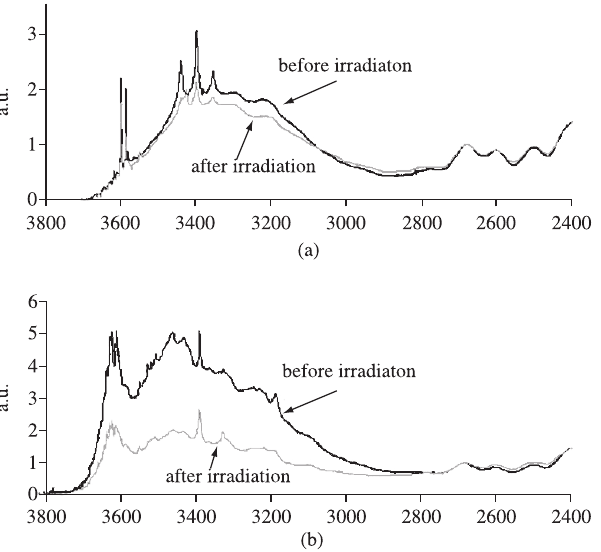
Figure 4. Infrared spectra at 93 K of a) amethyst from Brumado, Bahia, Brazil and b) prasiolite from Uberlândia, Minas Gerais, Brazil before and after irradiation with gamma rays up to 600